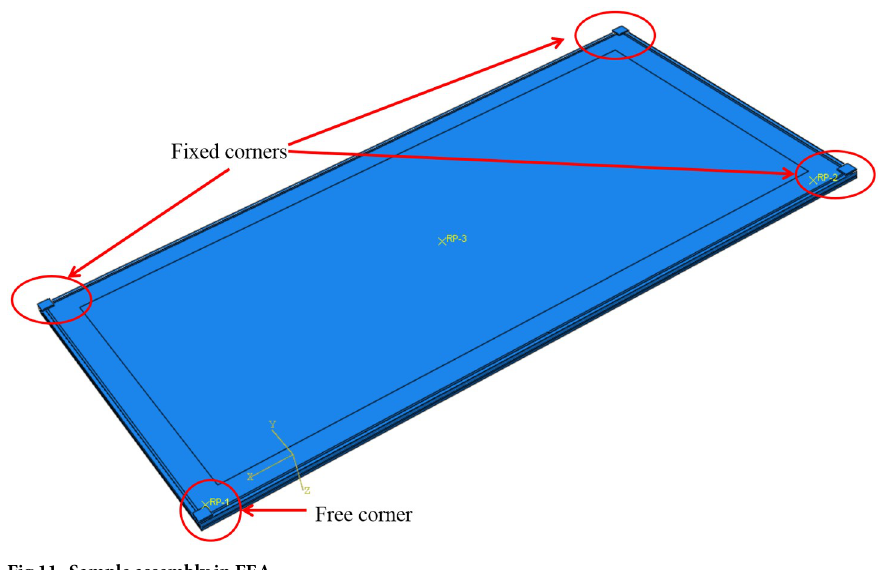
Fig 11. Sample assembly in FEA.